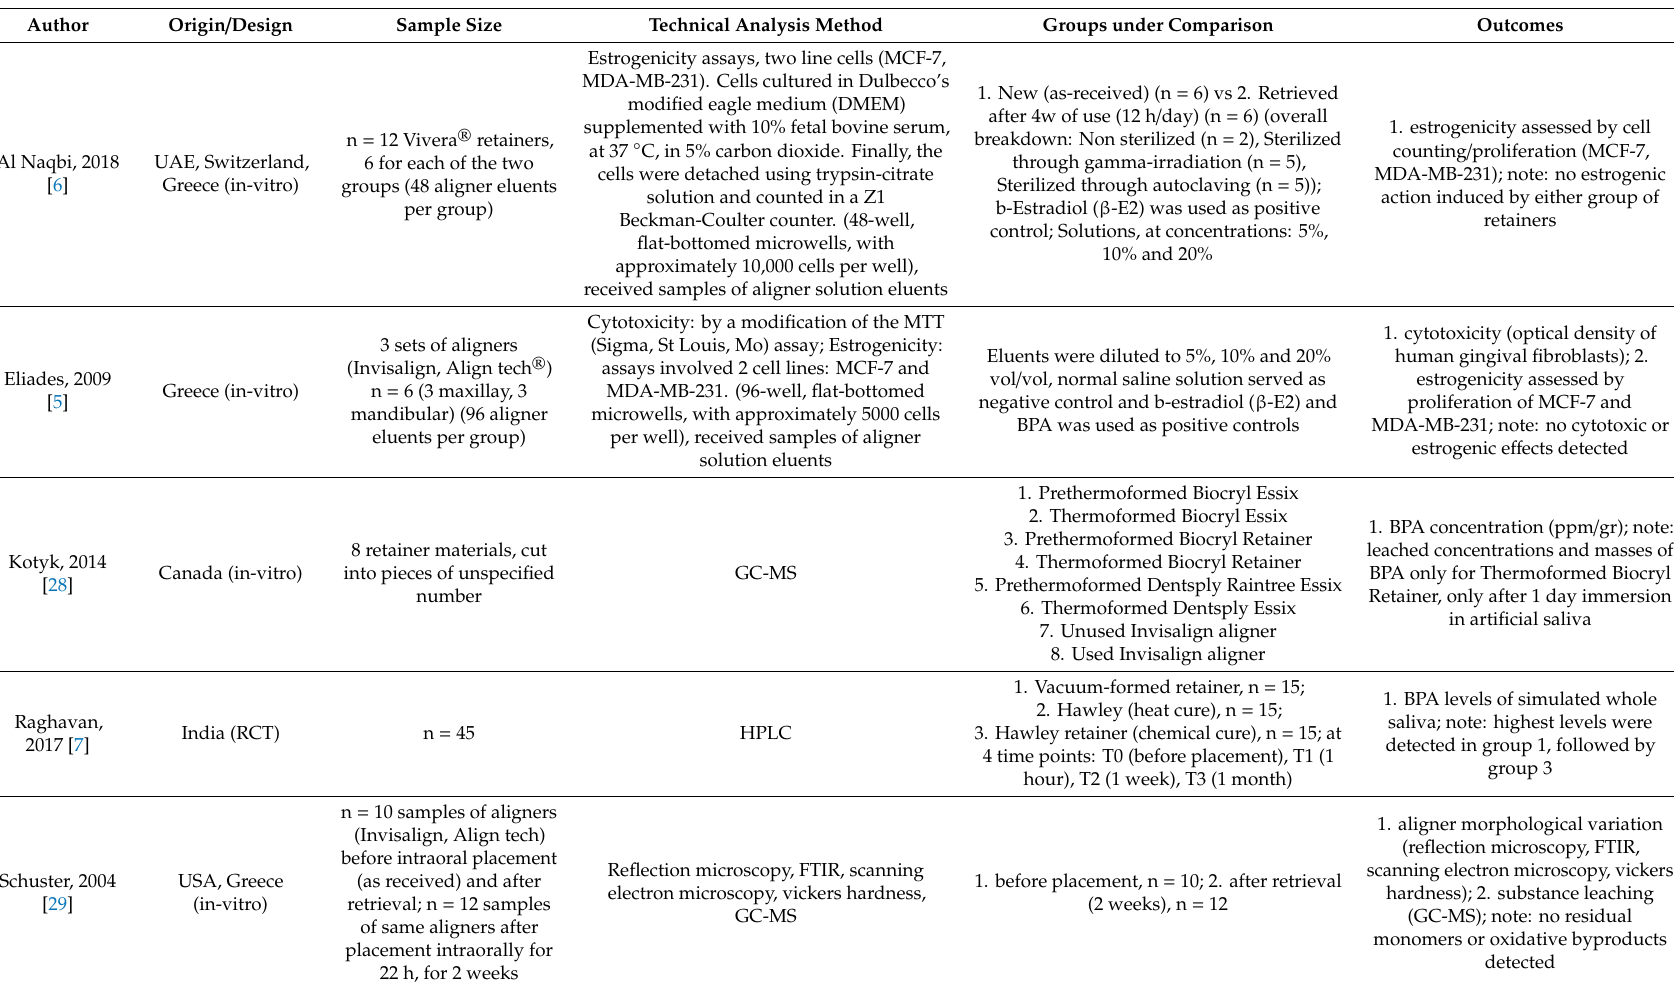
Table 1. Data extraction information for included studies (origin, study design, sample size, technical analysis methodology, comparisons and